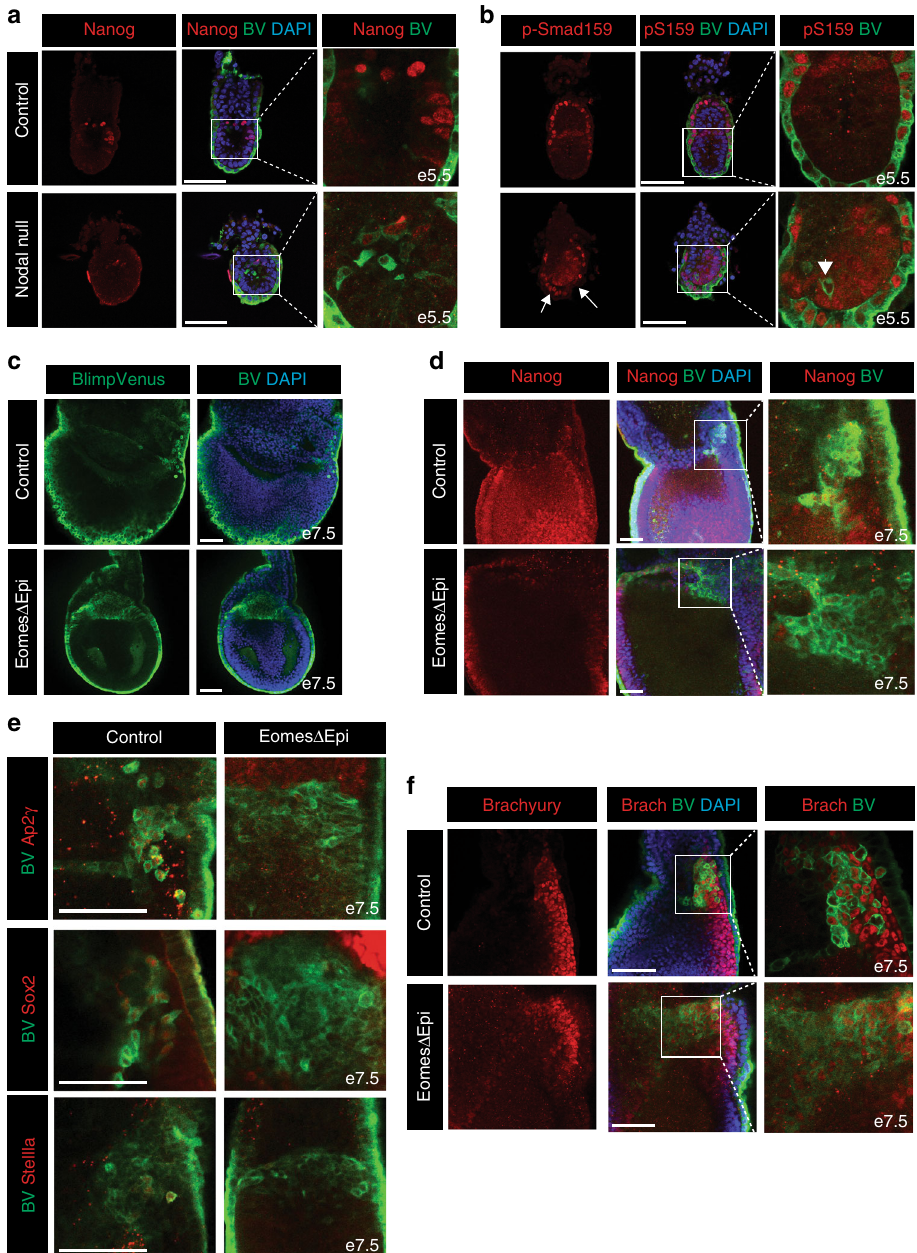
Fig. 2 Nodal and its downstream target Eomes regulate early stages of PGC development. a Reduced levels of Nanog expression in e5.5 Nodal null BV + embryos. b Nodal null BV + embryos display an expansion of p-Smad159 staining in the distal VE, as indicated by arrows. Arrowhead indicates lowered p- Smad159 staining within BV + cells. c Expansion of the BV + cell population in Eomes Δ Epi embryos at e7.5. d Nuclear Nanog staining in Eomes Δ Epi and control BV + embryos at e7.5. e Analysis of Ap2 γ , Sox2 and Stella in e7.5 control and Eomes Δ Epi BV + cells. f Brachyury staining in control and Eomes Δ Epi BV + e7.5 embryos. All IF images are counter stained with DAPI. Scale bars = 100 μ